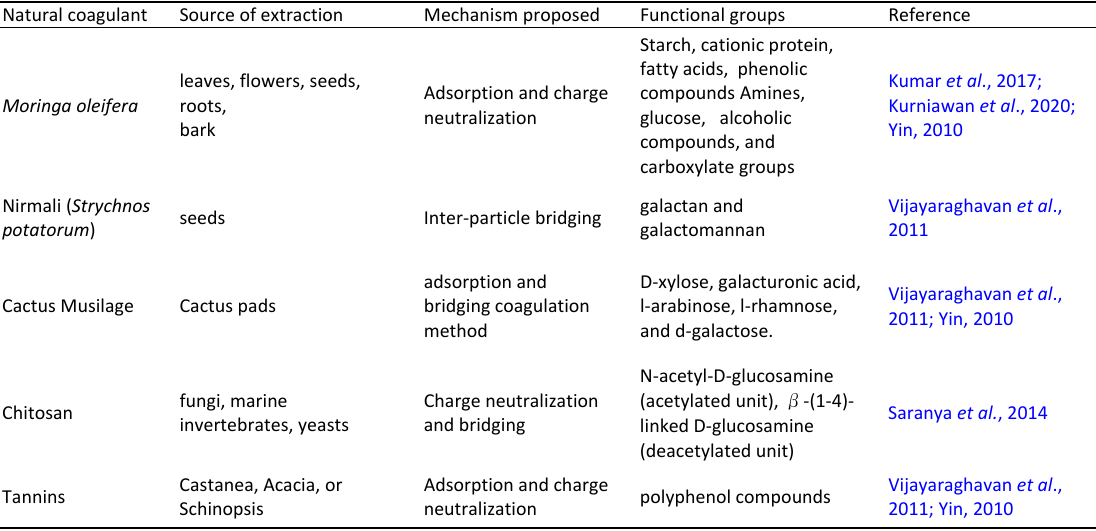
Table 1: Summary of functional groups and mechanism proposed for natural coagulants